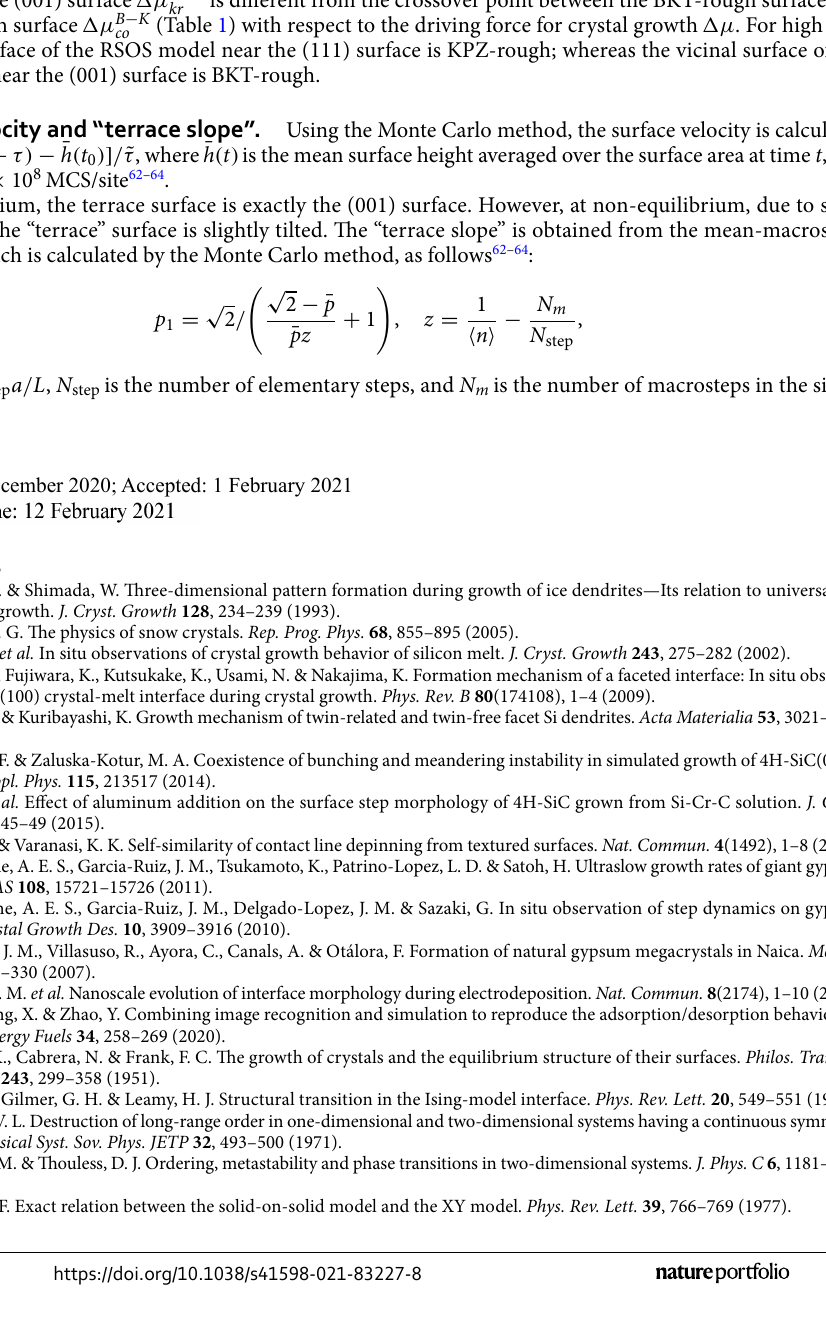
(Table 1) with respect to the driving force for crystal growth �µ . For high �µ